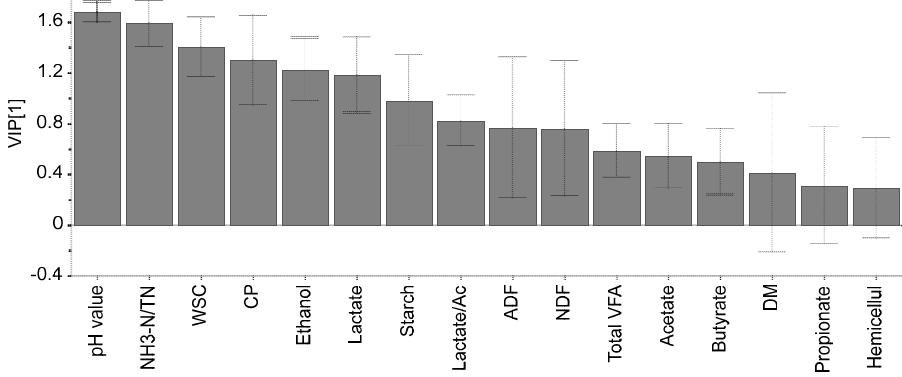
Figure 2. Histogram plot of the variable importance for the projection (VIP) in corn stalk silage inoculated with Saccharomyces cerevisiae alone or jointly with Lactobacillus plantarum . VIP [1] = VIP score based on principal component 1. Confidence intervals for the VIP values at the 95% level are shown as vertical bars. NH 3 -N / TN: Percentage of ammonia nitrogen to total nitrogen. WSCs = Water-soluble carbohydrates. Hemicellul: Hemicelluloses. VFAs include acetate, propionate, and butyrate. Lactate / Ac = Lactate:acetate